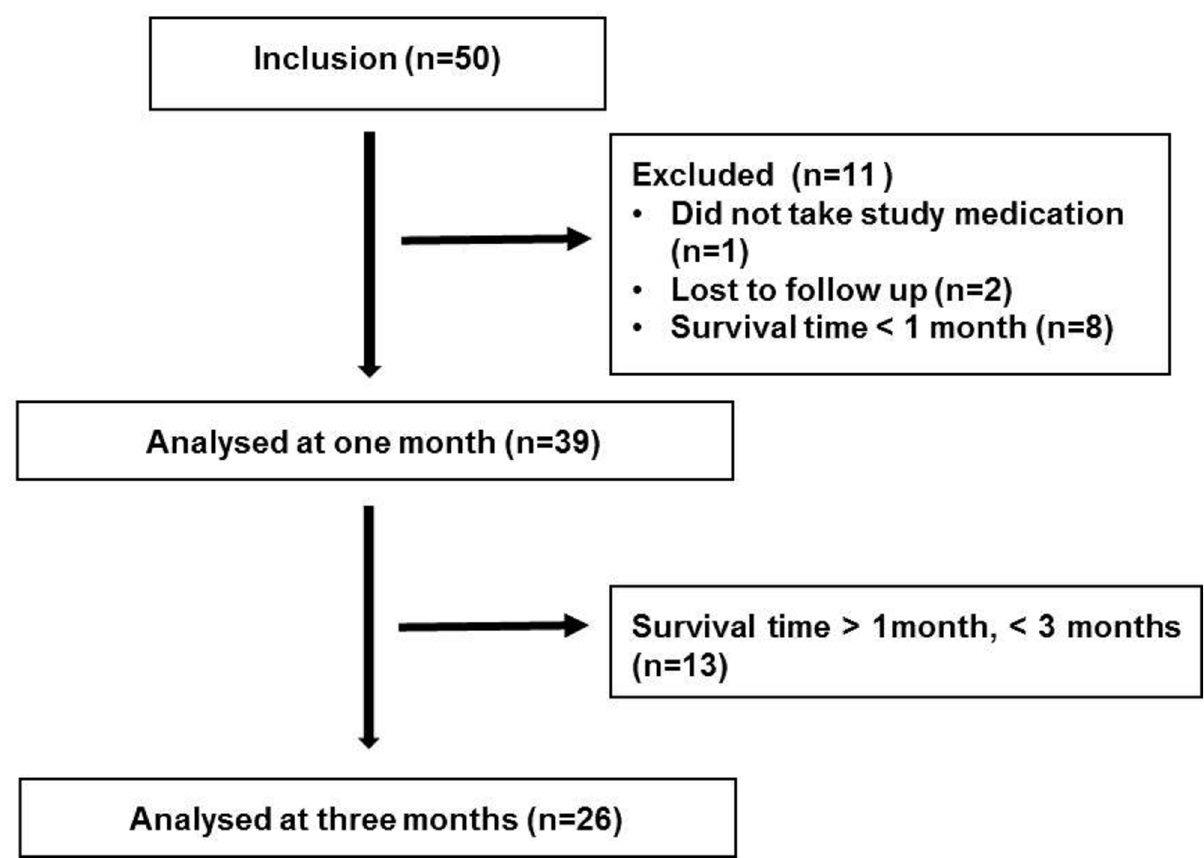
Fig 1. Flowchart of patients included in the vitamin D intervention study.